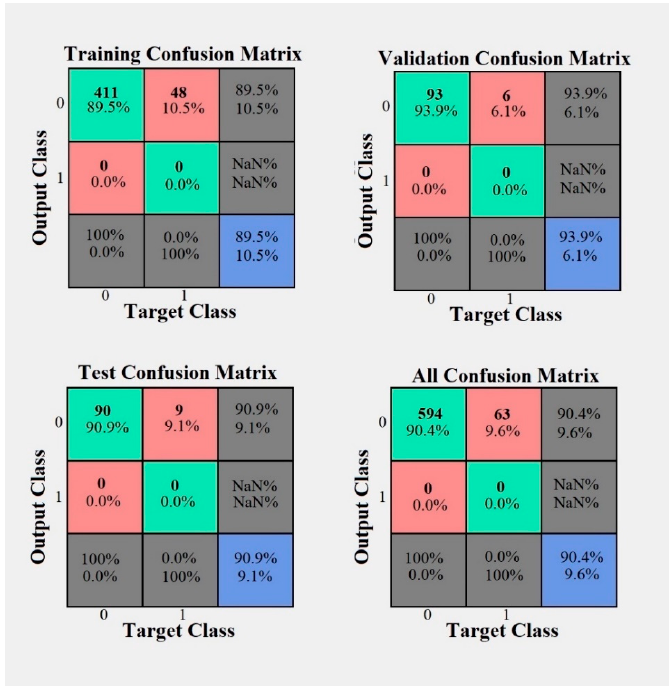
Figure 10. Error matrix of a network using polynomial coefficients with the degree N = 3.